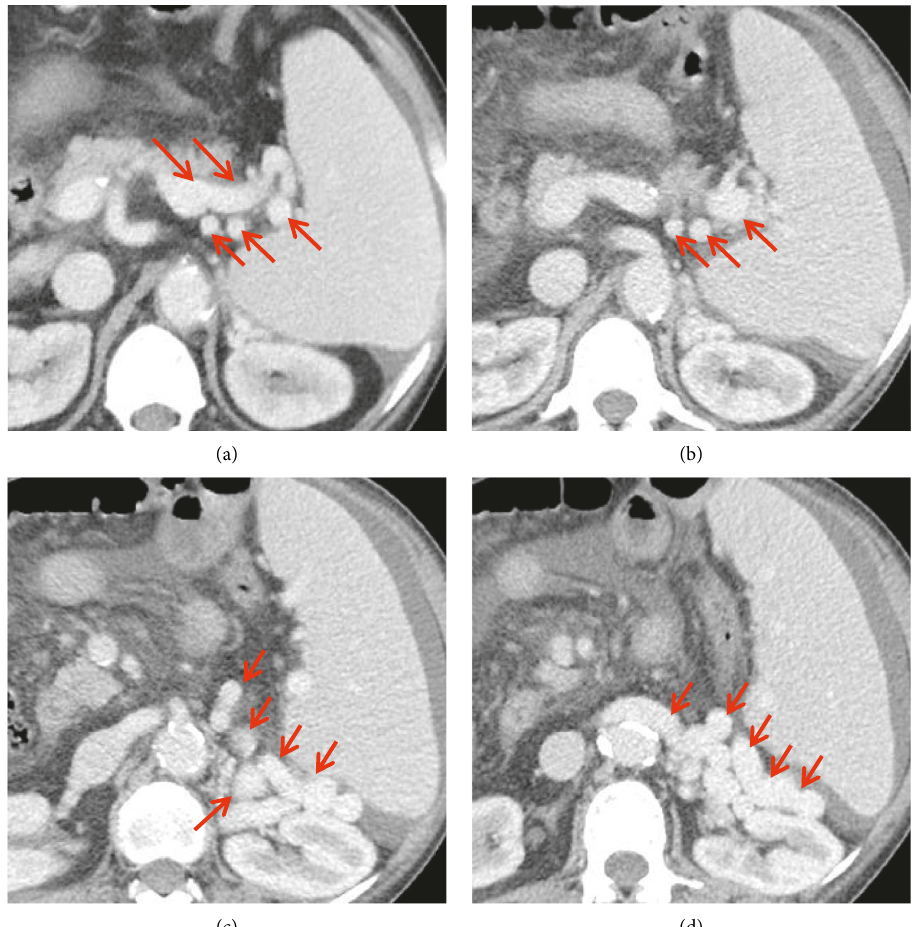
Figure 9: Splenorenal shunt. In a 62-year-old female with liver cirrhosis, the axial contrast-enhanced CT scan on the portal vein phase demonstrated that splenorenal shunt (red arrow) manifested as enhancement of abnormally dilated vessels originating from the splenic vein to the left renal vein.